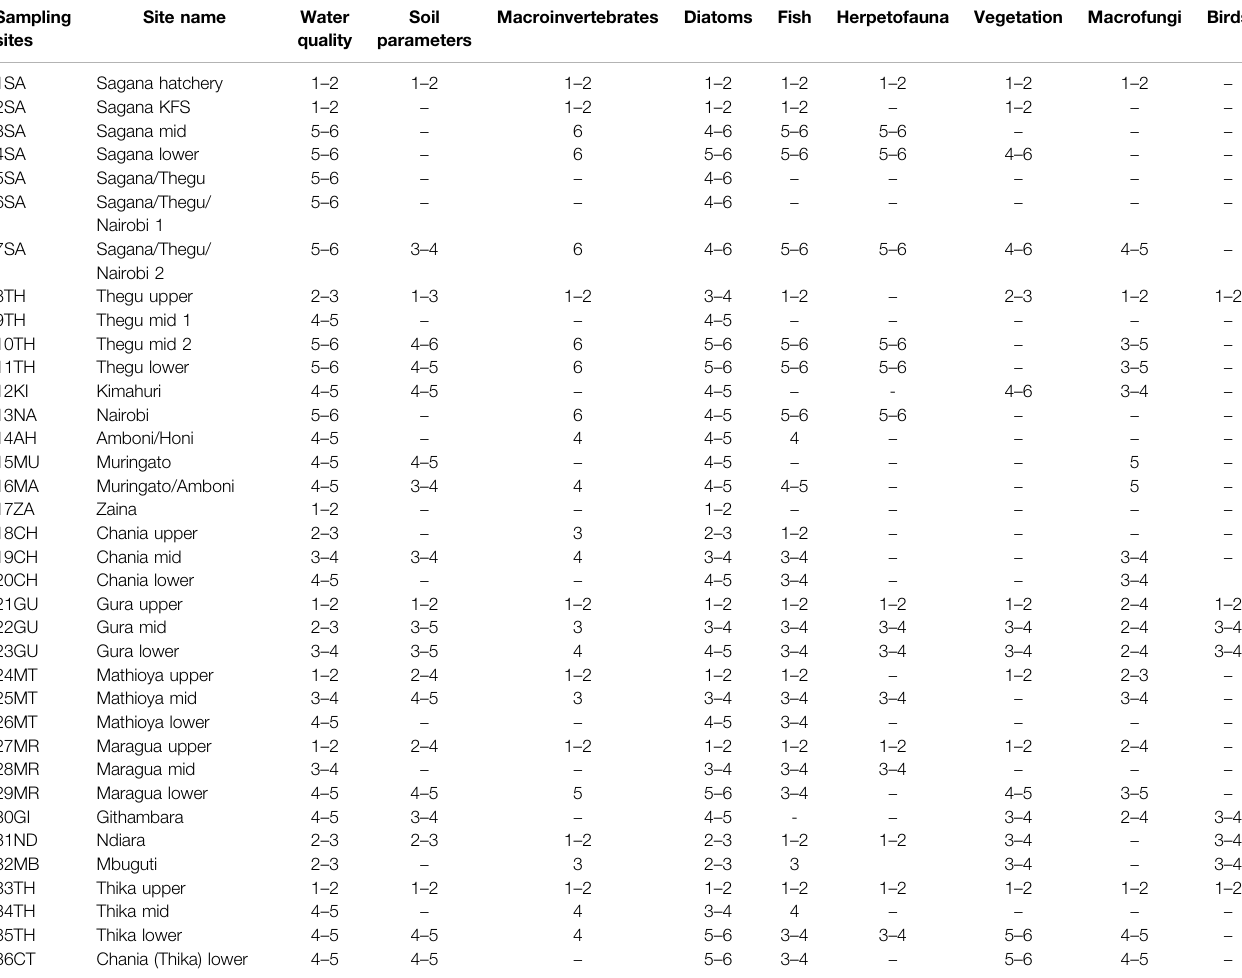
TABLE 1 | Characterizing sampling sites into tiers using water quality, soil parameters, and various taxonomic groups ( − ) (cid:2) signify no data or inadequate data. Sampling